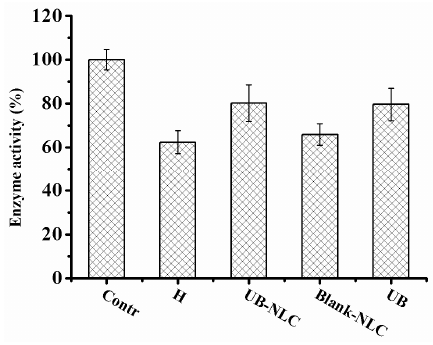
Figure 10. GSH-PX activity of HaCaT cells during culture period with or without UB-NLC.